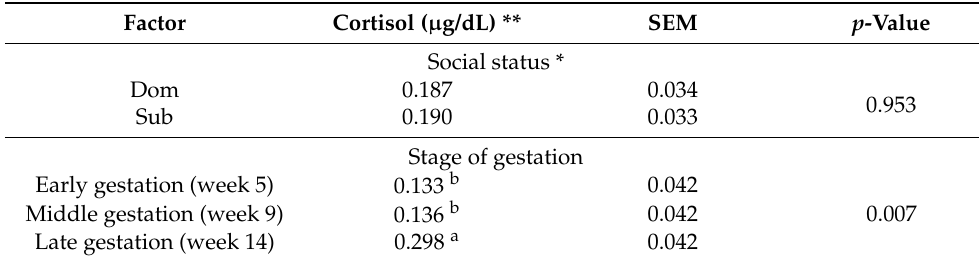
Table 8. Saliva cortisol levels ( µ g/dL) in Dom and Sub